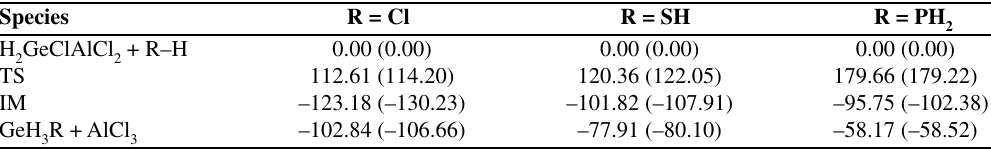
Table 2. Relative energies (in kJ/mol) of transition states (TSs), intermediates (IMs), and products of the substitution reactions of H GeClAlCl with R-H (R = Cl, SH, PH 2 2